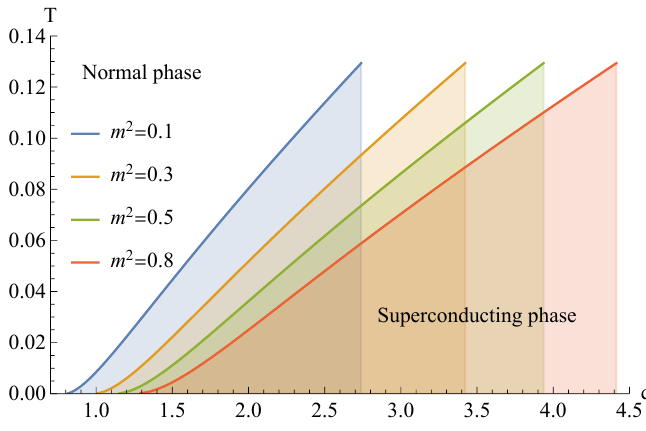
Figure 3 . The phase diagram of holographic p-wave superconductor model with positive m 2 . The solid lines are the critical